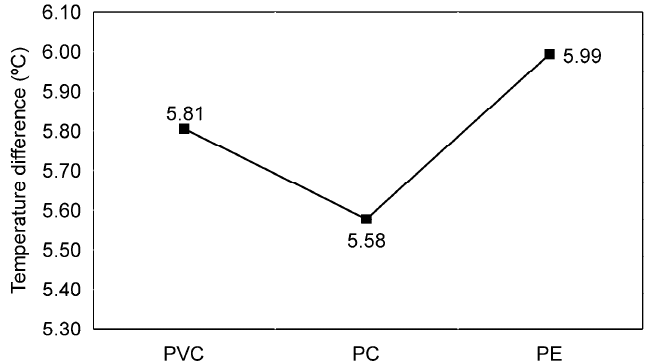
Figure 12. The temperature difference between x = 0 m and x = 20 m for different materials.